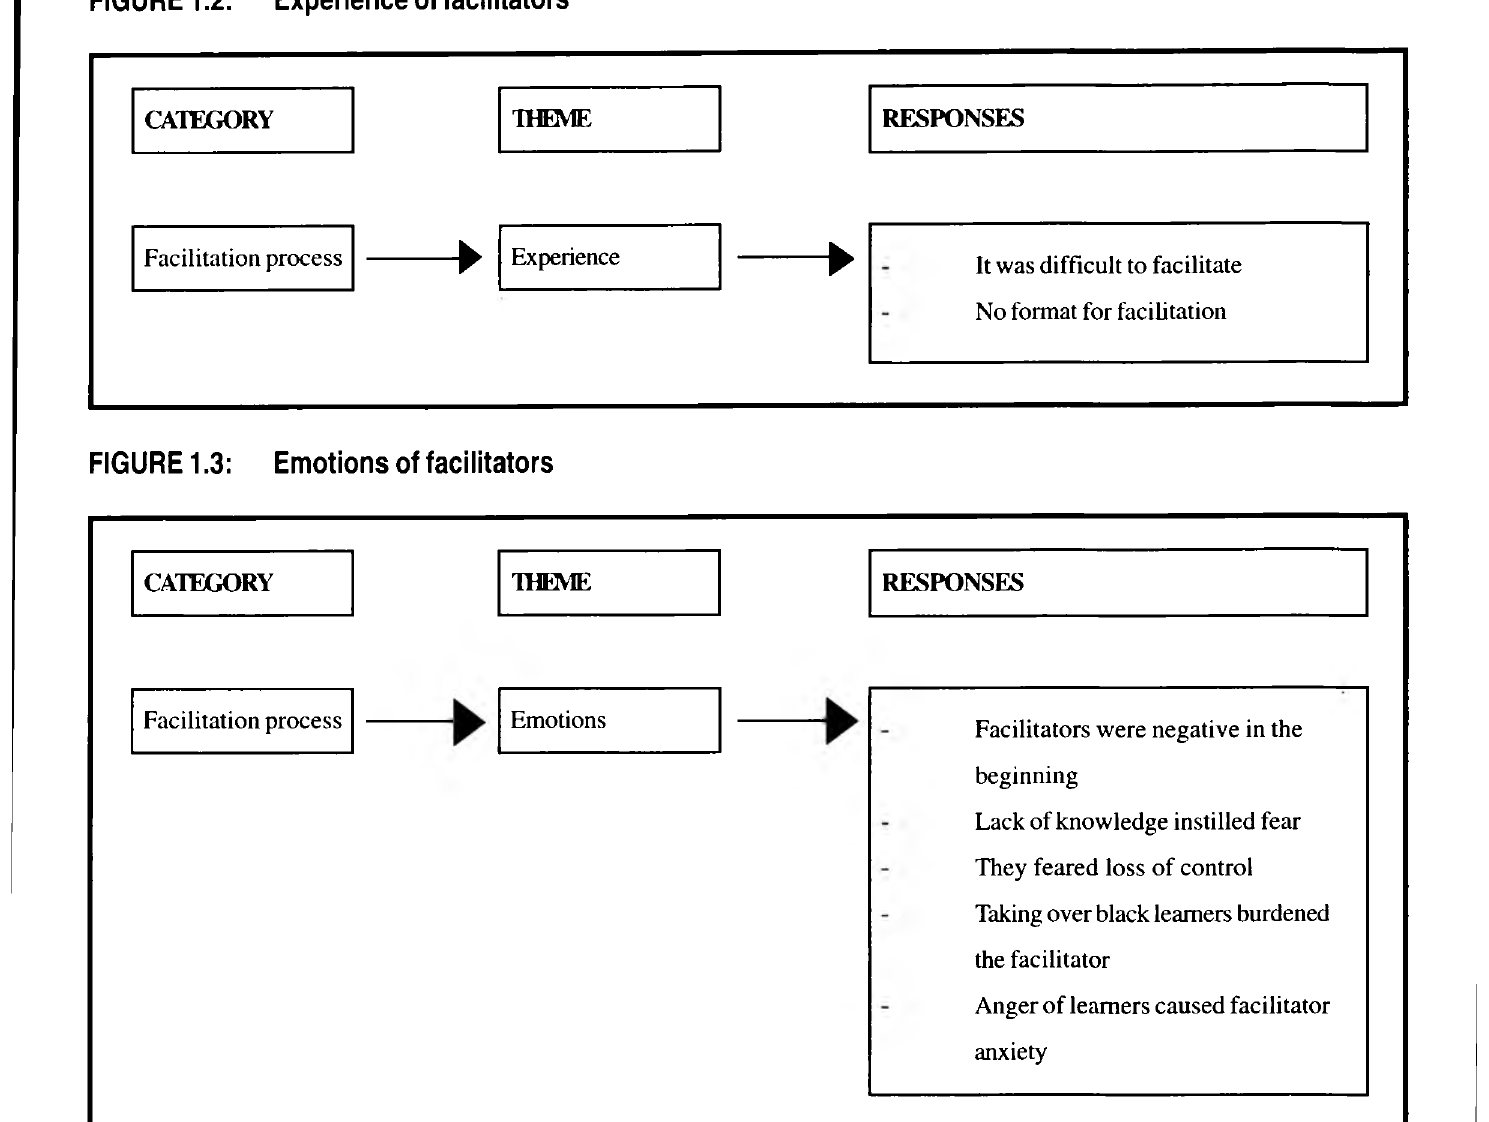
FIGURE 1.2: Experience of facilitators